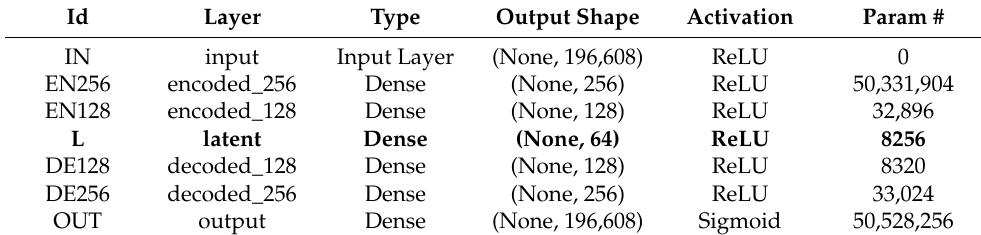
Table 2. MLP baseline training model. Bold indicates the latent